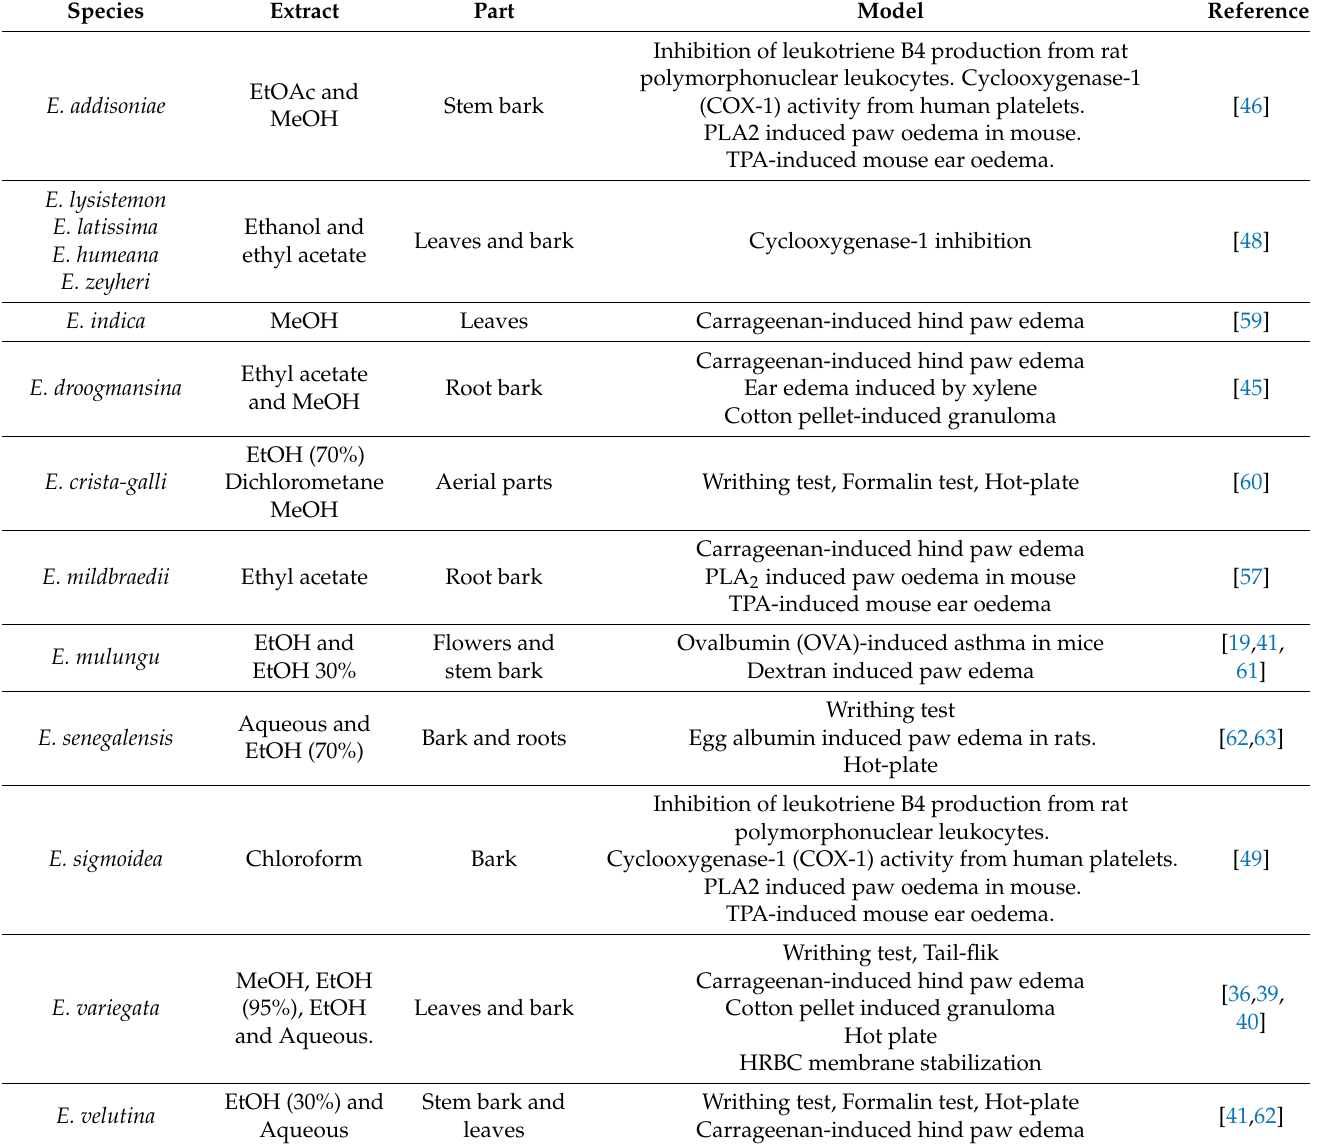
Table 2. Preclinical studies on the analgesic and anti-inflammatory effect of species of the genus Erythrina. Species Extract